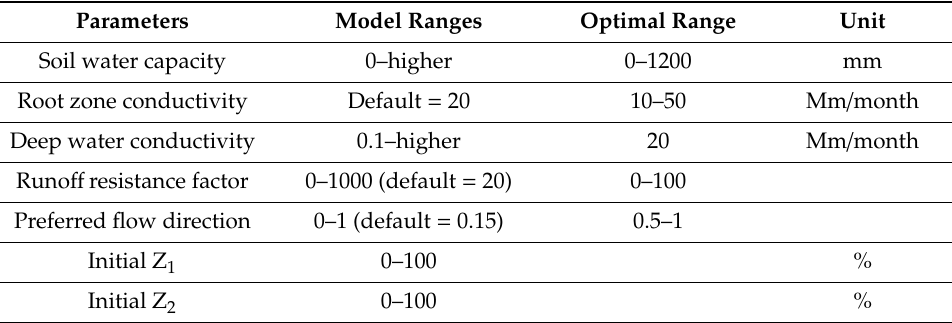
Table 4. The calibration parameters’ possible ranges used in the WEAP model.